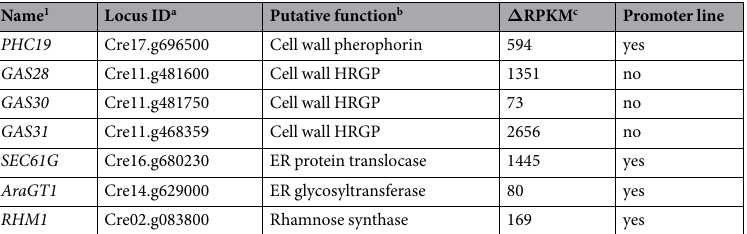
Table 1. Genes of interest selected from curated transcriptome data. a According to the Chlamydomonas annotation 5.6 (https://phytozome.jgi.doe.gov/). b According to Joo et al . 23 . c Difference in Reads Per Kilobase transcripts per Million reads (RPKM) between untreated and g-lysin-treated gametes, based on Ning et al . 22